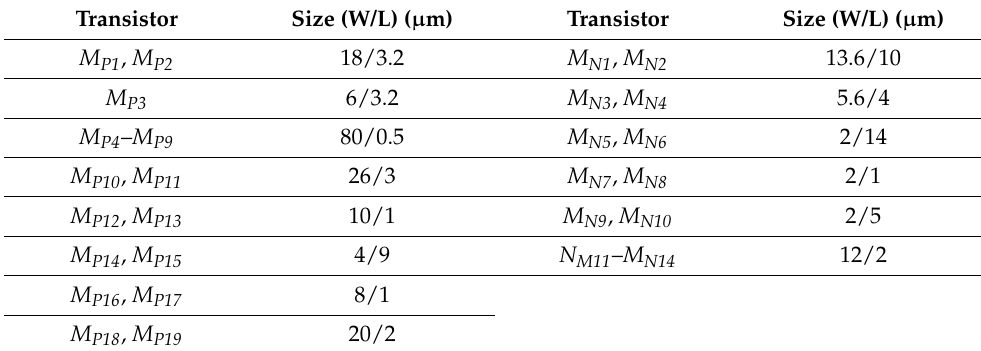
Table 1. Values of transistors in the proposed CFIA.